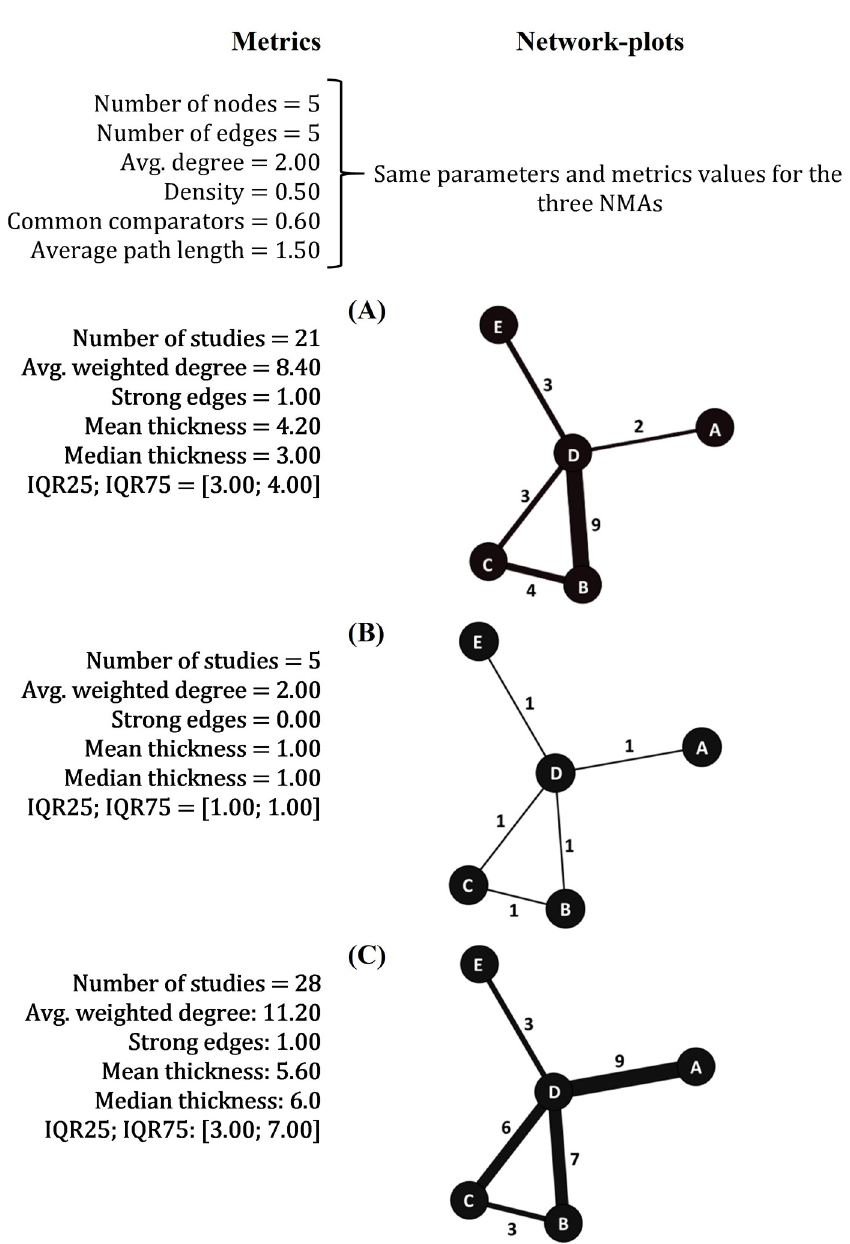
Fig 3. Sensitivity analyses for the assessment of NMAs with equal geometry and different numbers of studies. Examples of three networks-plots from the 167 analyzed NMAs. Highlighted parameters showed different values among similar